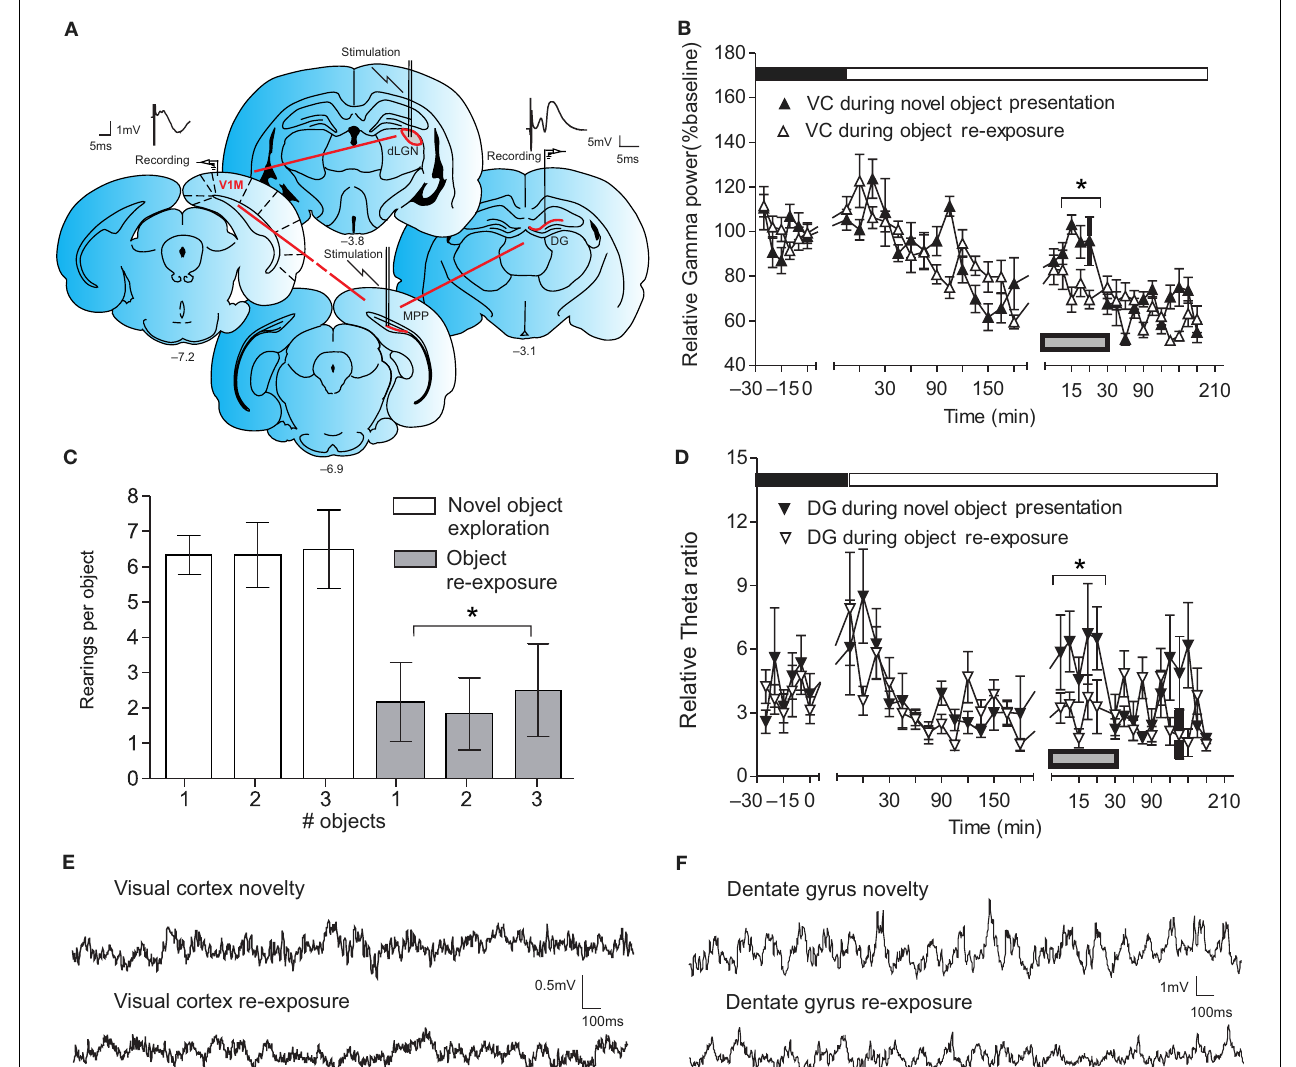
FIGURE 1 | Novelty-evoked high-frequency cortical oscillations parallel the induction of theta rhythms in the dentate gyrus. (A) Schematic presentation of cortico-hippocampal information fl ow and illustration of the location of implanted electrodes. The red arrows indicate the direction of synaptic transmission and the interrupted red arrow implies polysynaptic transmission between the indicated structures. The bipolar stimulating electrode in dLGN and the monopolar recording electrode in the primary visual cortex [V1M] represent the thalamocortical contact. Stimulation and recording electrodes in the MPP and the dentate gyrus (DG), respectively, show the entorhino-hippocampal interaction. Analog traces represent the evoked fEPSPs in the visual cortex (VC) and DG. Electrodes’ anterior-posterior coordinates relative to bregma are indicated below the drawings. (B) Novelty exploration (the presentation of the objects is indicated by the gray rectangle) leads to increased gamma oscillations in VC ( n = 4). During re-exposure to the objects a reduction in visual cortex gamma activity was observed ( n = 4). To exclude the interference of diurnal fl uctuation of basal synaptic transmission in VC on the novelty protocol, baseline